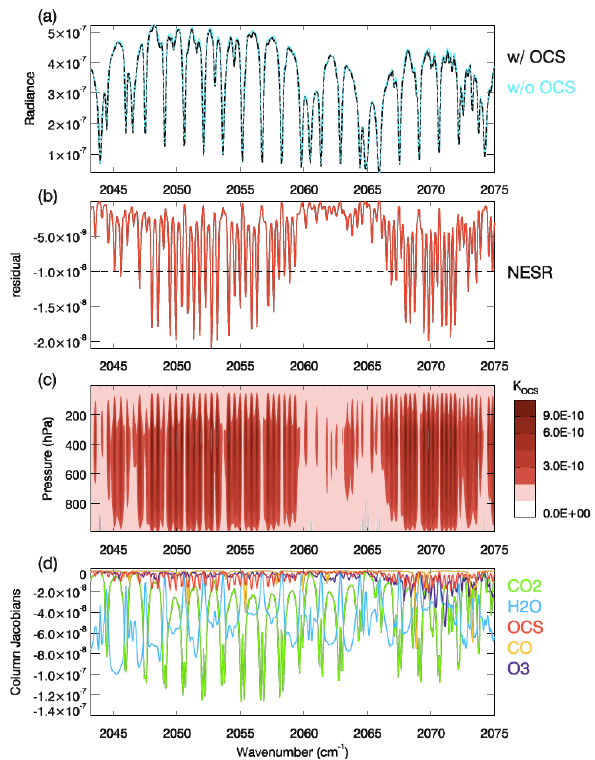
Fig. 1. (a) Model calculated radiances without OCS profile (blue line) and with OCS profile (black dash line); (b) residuals between the two models calculated radiances in (a); it is the same as OCS vertically integral Jacobians, the red line in (d); the dash line represents the Noise Equivalent Spectral Radiance (NESR), 1E-­‐8 Wcm −2 sr −1 cm −1 ; (c) contour plot for OCS Jacobians; (d) vertically integral Jacobians for CO 2 (green), H 2 O (blue), OCS (red), CO (orange) and O 3 (purple).